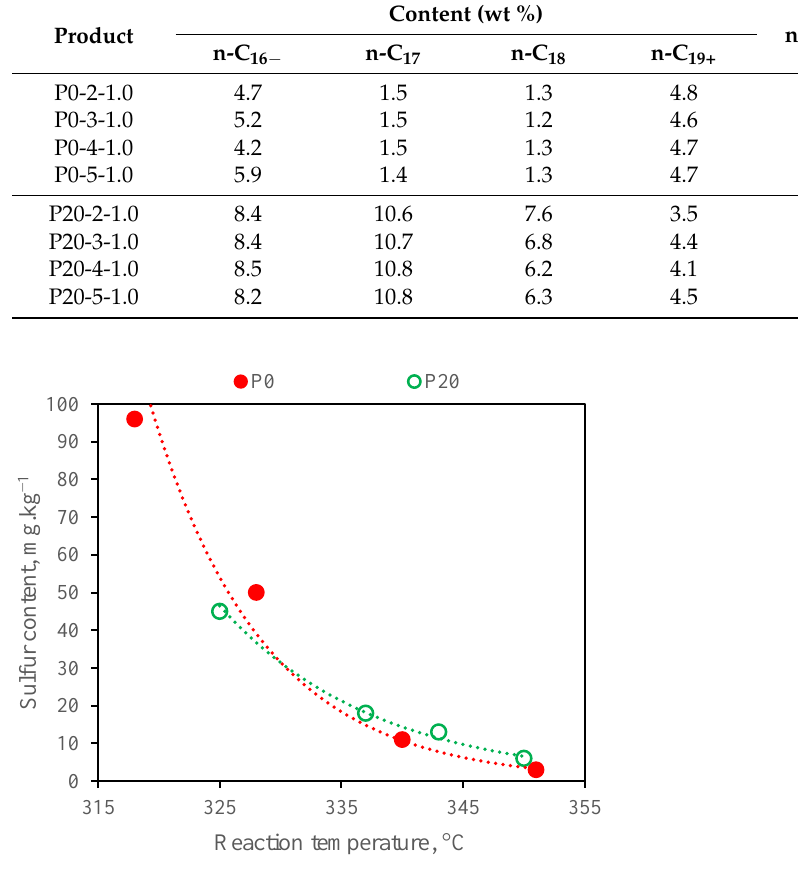
Figure 2. The sulphur content in the liquid products from F0 and F20 feedstocks obtained at a WHSV of 1.0 h − 1. Table 2. The selected properties of the feedstocks and liquid products obtained at a WHSV of 1.0 h − 1